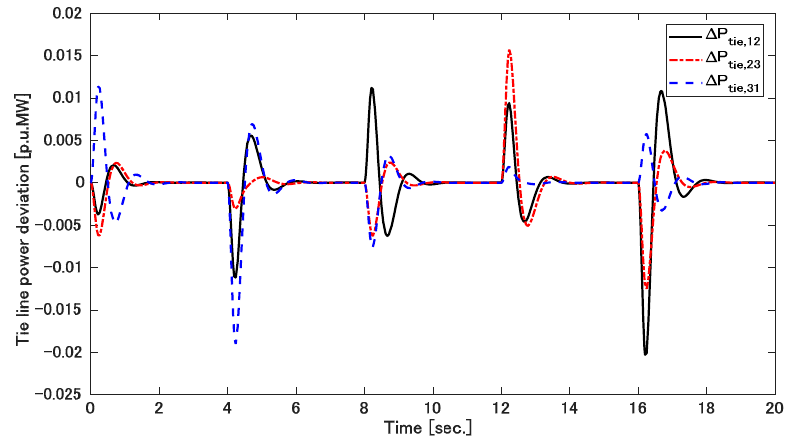
Figure 20. Tie-line power deviation without wind plant.